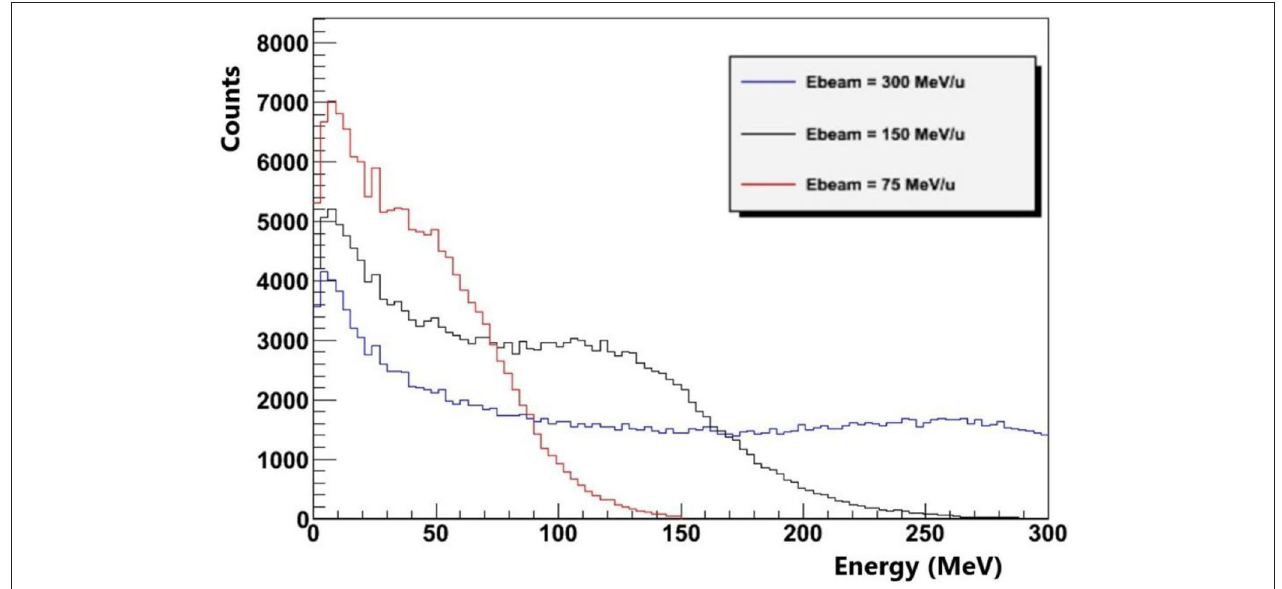
FIGURE 3 | Geant4 simulation of the energy distribution of secondary protons at emission inside a thin PMMA target by carbon ions at three different energies. Nuclear reactions are modeled with the QMD model (data from [ 33]).